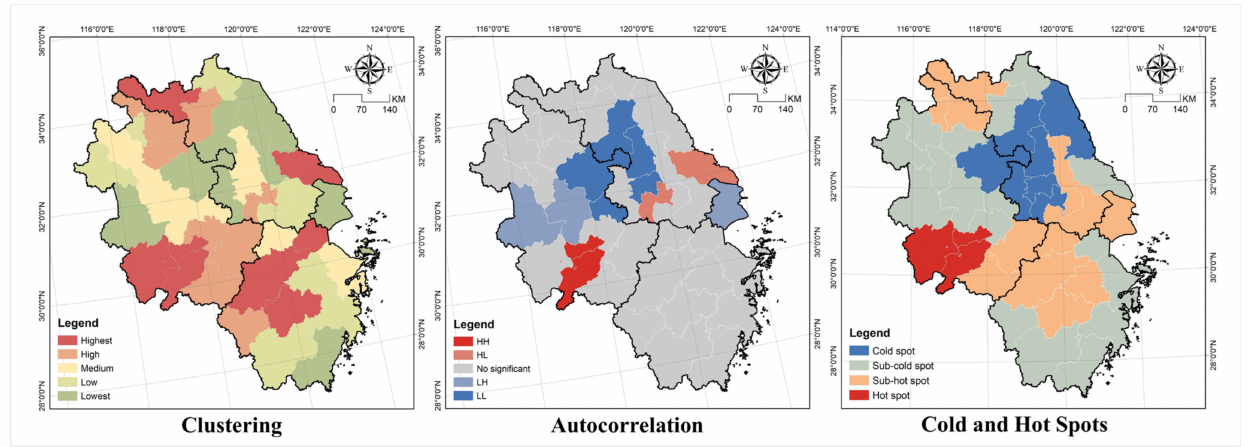
Figure 7. Spatial analysis of the change speed in